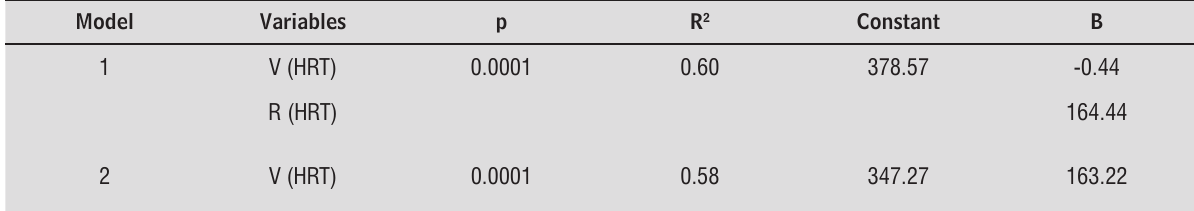
Table 2 - Linear regression considering the total sample of participants between 50 and 59 years Model